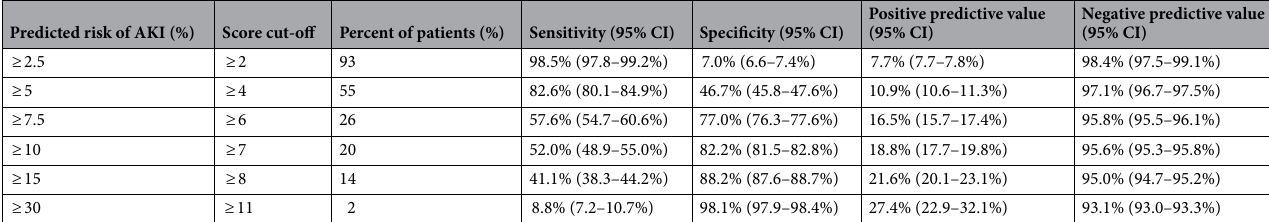
Table 3. Score cut-offs of the predicted risk of AKI based on AKI-RiSc, including percentage of patient within score threshold, sensitivity, specificity, positive predictive value, and negative predictive value. AKI acute kidney